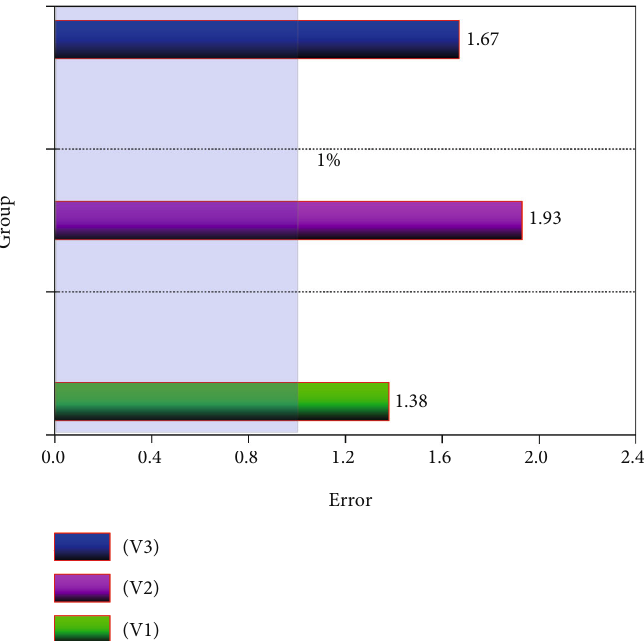
Figure 5: The prediction error distribution of three characteristics of English teaching by using the ConvLSTM method.